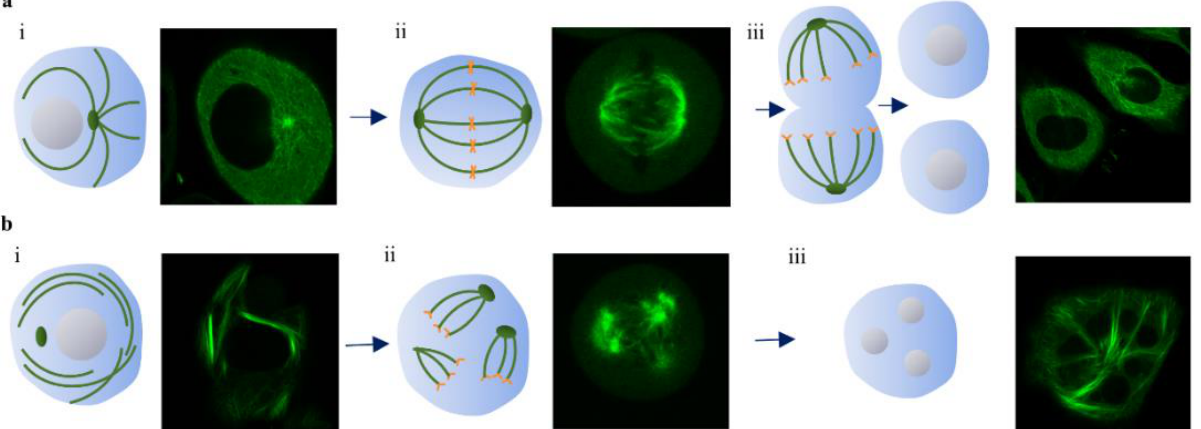
Figure 8. Schematic diagram and confocal images of cell division showing microtubules under normal conditions ( a ) and 50 nM DTX ( b ). ( a ) (i) Quiescent normal cell, (ii) normal mitotic spindle, (iii) normal pair of daughter cells. ( b ) (i) Asters formation in non-dividing cell with DTX, (ii) fragmentary division with 10 nM DTX, and (iii) mitotic arrest with multinucleation under 50 nM DTX. Adapted with permission from [92], Europe PMC, 1997.